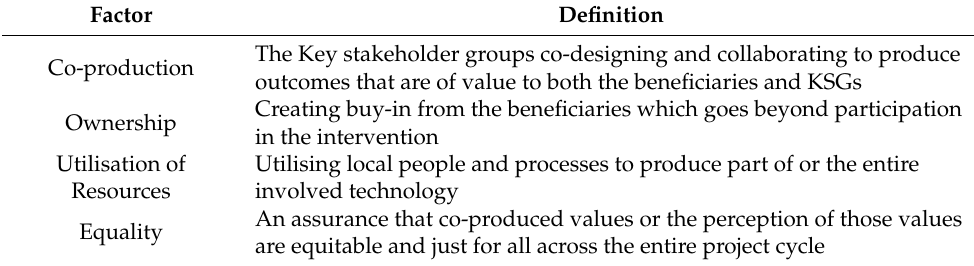
Table 1. TIME Definitions